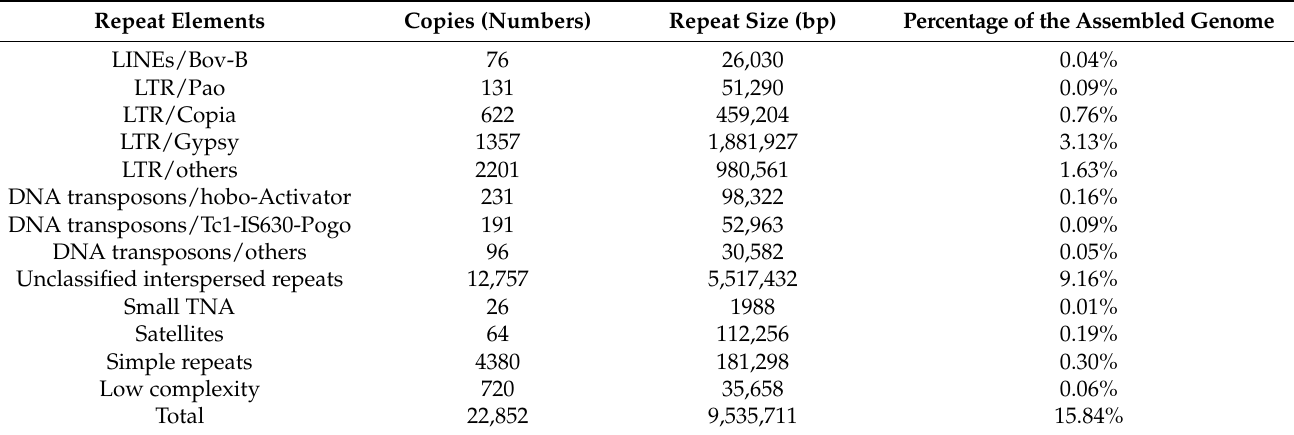
Table 2. Repeat element analysis in the P. giganteus genome.